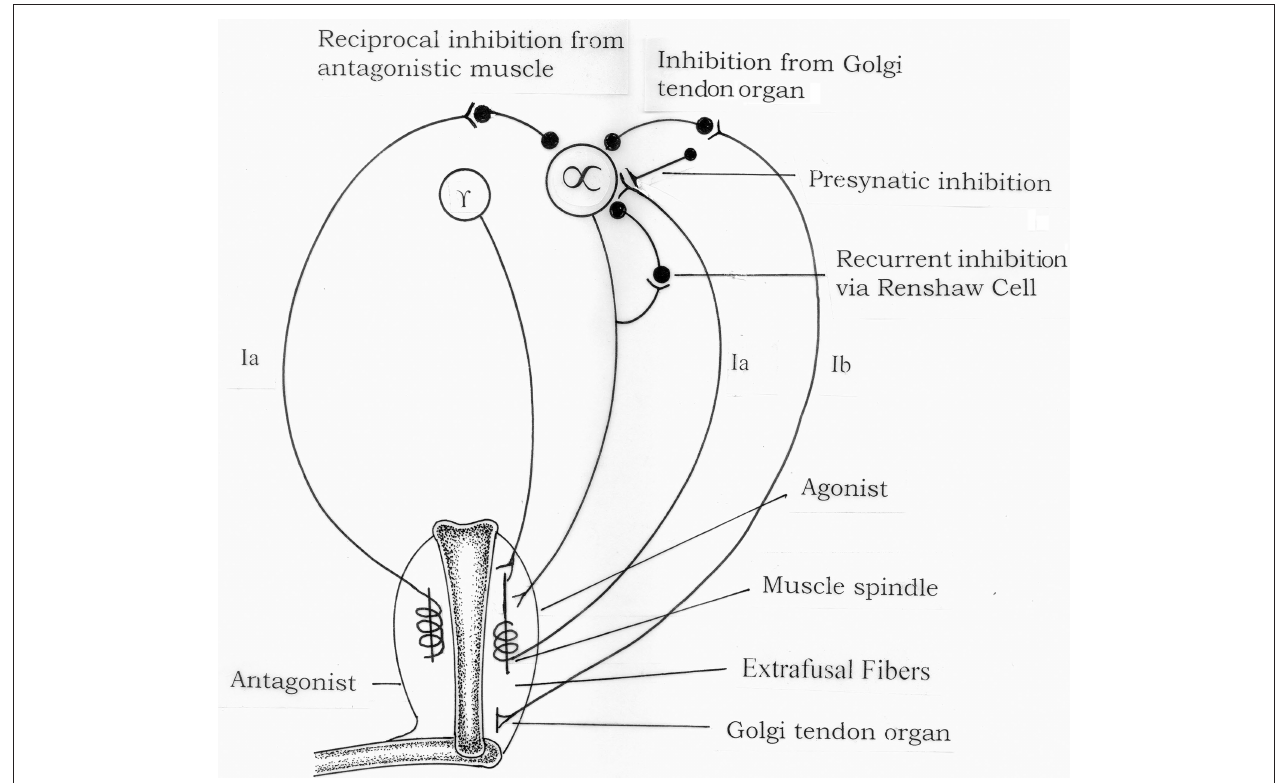
Figure 2 | Spinal pathways which may be responsible for development of